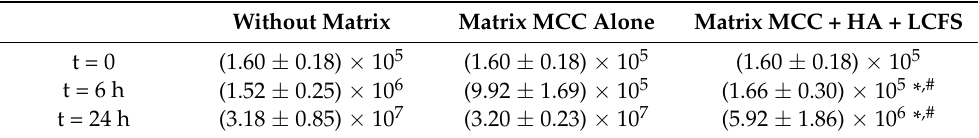
Table 2. Viability of C. albicans SO1 in culture medium (SD broth) with and without MCC vaginal matrices containing HA and LCFS. MCC matrices without active molecules were used as control. Microbial concentration was assessed at the inoculum time (t = 0) and after 6 (t = 6 h) and 24 (t = 24 h) hours of incubation and expressed as mean CFU/mL ± standard deviation. Without Matrix Matrix MCC Alone Matrix MCC + HA + LCFS t = 0 (1.60 ± 0.18) × 10 5 (1.60 ± 0.18) × 10 5 (1.60 ± 0.18) × 10 5 t = 6 h (1.52 ± 0.25) × 10 6 (9.92 ± 1.69) × 10 5 (1.66 ± 0.30) × 10 5 * ,# t = 24 h (3.18 ± 0.85) × 10 7 (3.20 ± 0.23) × 10 7 (5.92 ± 1.86) × 10 6 * ,# * p < 0.005 vs. control without matrix, # p < 0.005 vs. MCC